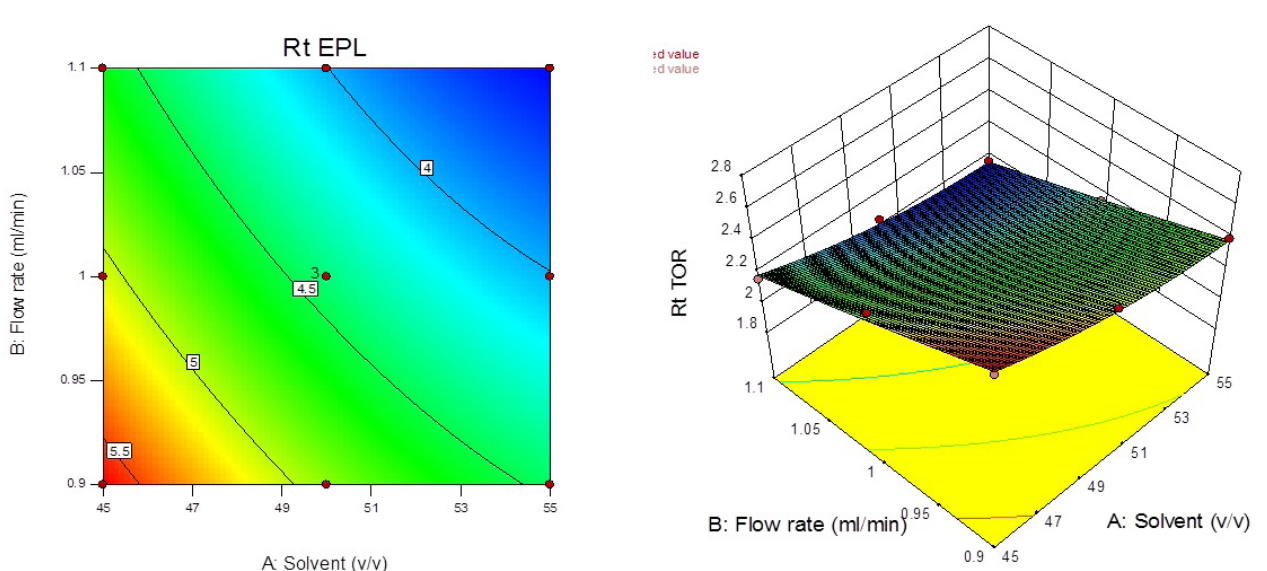
FIGURE 4 - 2D (A) and 3D (B) contour plots showing the effect of mobile phase ratio (X of EPL (Y ). 2